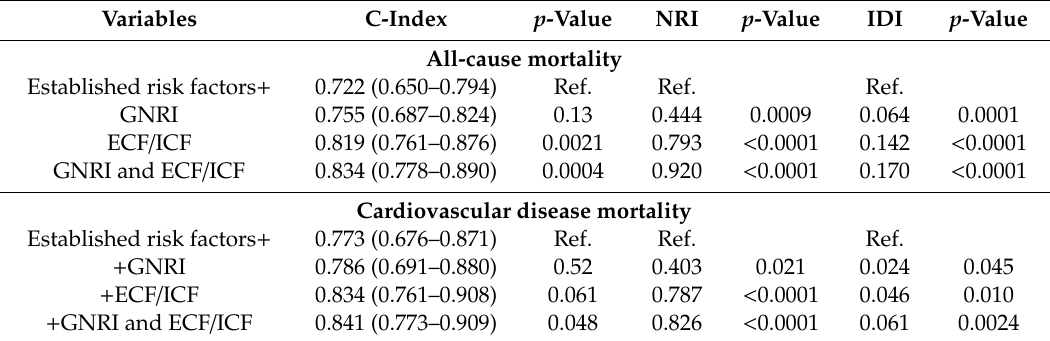
Table 4. Predictive accuracy of the GNRI and ECW / ICW ratio for